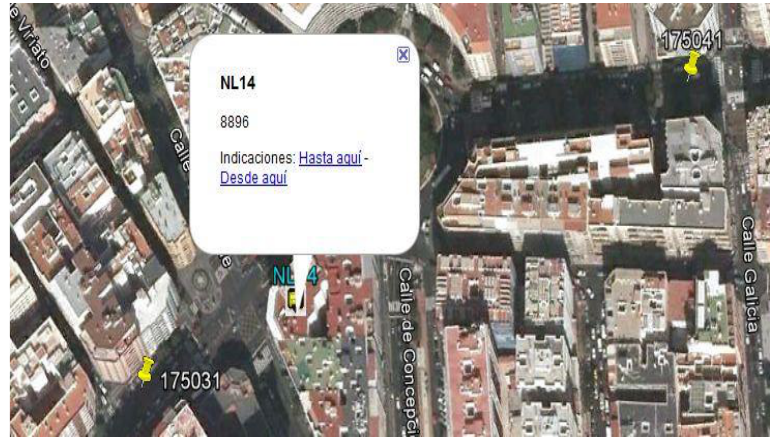
Figure 7. Result after applying a second iteration of the method to the cluster shown